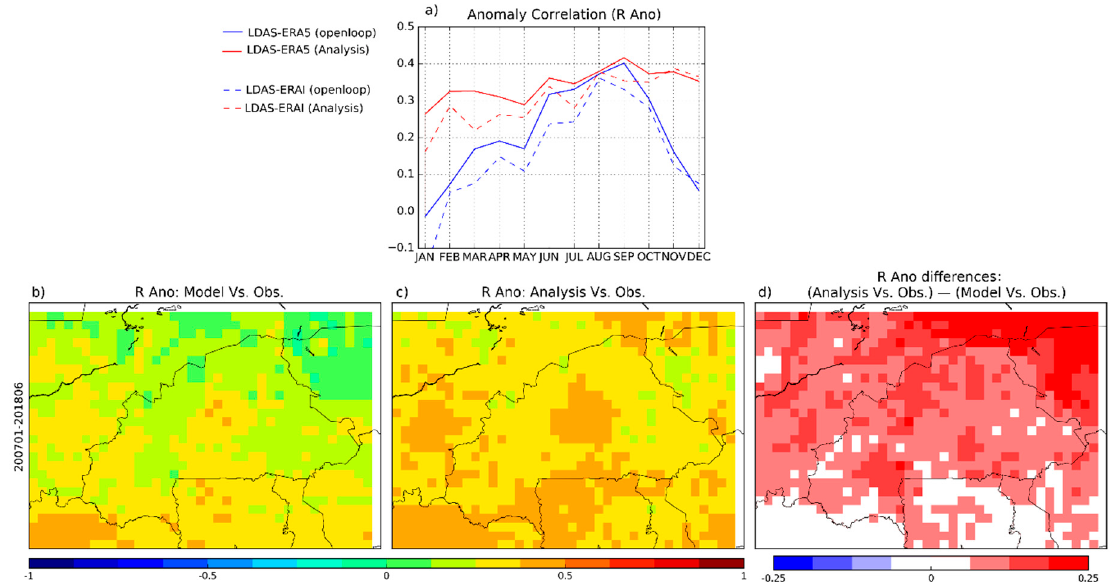
Figure 12. Averaged analysis increments for January 2001 to June 2018. Four control variables are illustrated: (a) leaf area index and soil moisture in (b) the second (WG2, 1–4 cm), (c) fourth (WG4, 10–